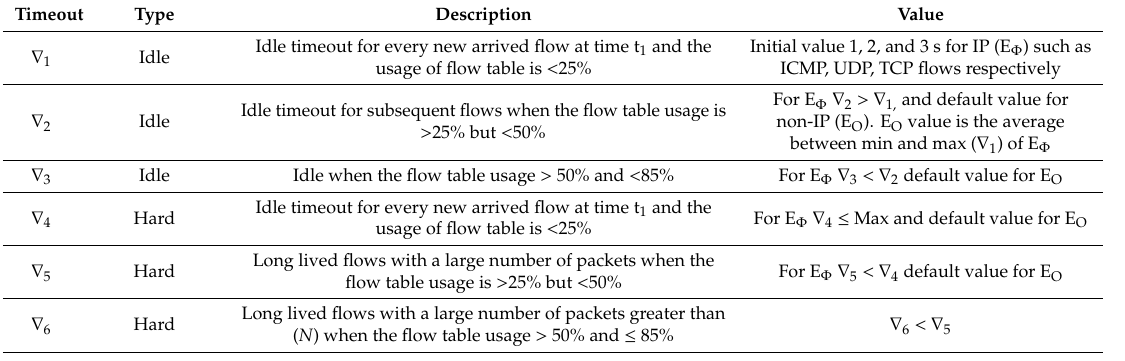
Table 2. Summary of the flow configurable timeout values of idle–hard timeout allocation (IHTA).